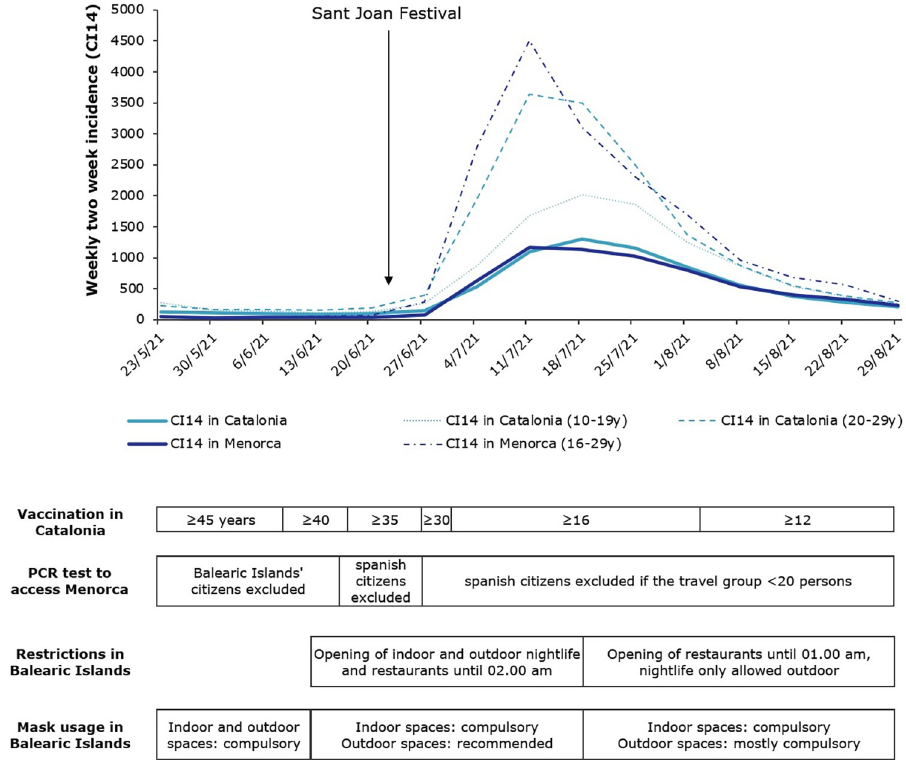
Fig 1. Evolution of weekly two-week incidence (CI14) in Catalonia and Menorca per 100 000 in summer 2021 and evolution of selected policies to control Covid-19 pandemics. Data for Catalonia was obtained from public repository https://dadescovid.cat; Data for Menorca was obtained from public repository https://www.ibsalut.es/ coronavirus-covid-19/situacio-actual-de-la-covid-19-a-les-illes-balears. Covid-19 preventive measures were obtained from the Butlletı´Oficial de les Illes Balears http://www.caib.es/boib/.